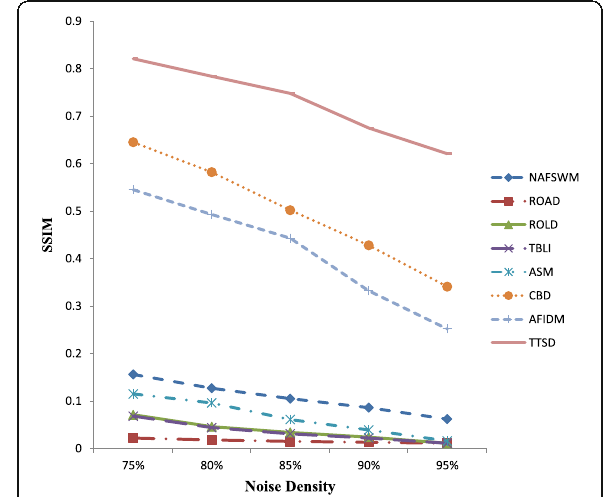
Fig. 10 Graph of comparison of SSIM of different methods for TID2008 database at 80% noise